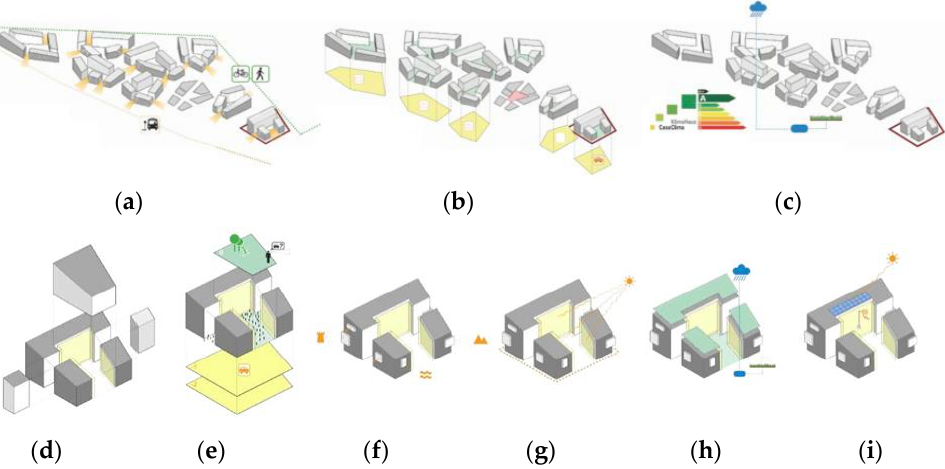
Figure 15. Design concept of CasaNova district. At the neighborhood level: ( a ) urban mobility and accessibility to the area, ( b ) social public spaces organization, ( c ) shadow cast and buildings’ morphology to reach the highest energy class according to the Italian energy certificate system. At the building level: ( d ) morphology of the building block, ( e ) internal connections and social spaces, ( f ) study of the views from the building stock, ( g ) study of the solar exposure and orientation, ( h ) green roofs and water management system, and ( i ) use of RES; (Source: © Wienerbeger).